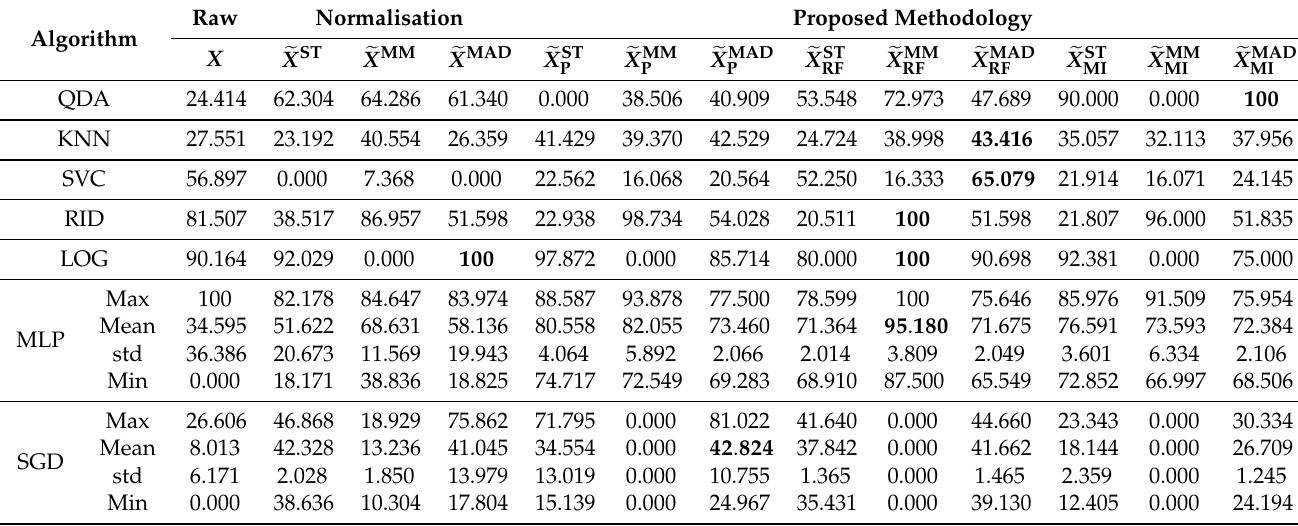
Table 8. Precision reached by each ML algorithm over the raw, normalised and transformed datasets.